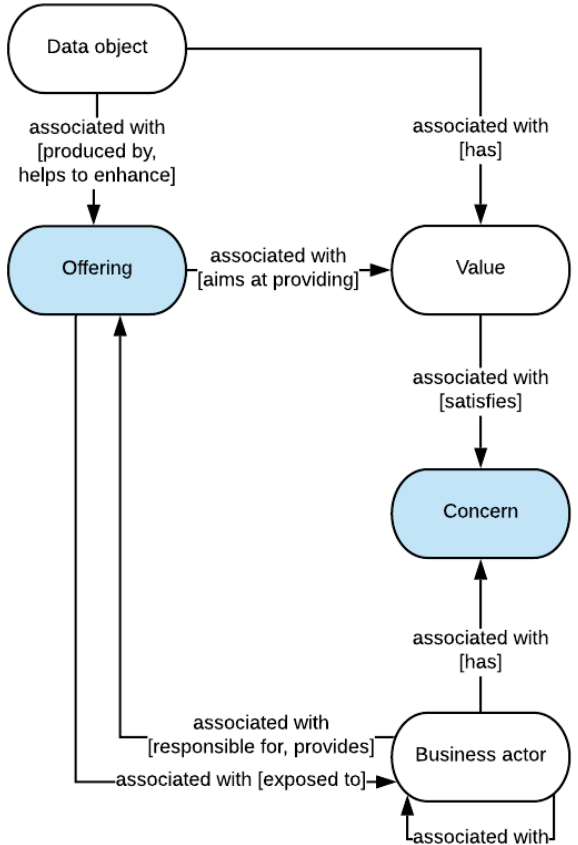
Figure 14. Business options focal area with included